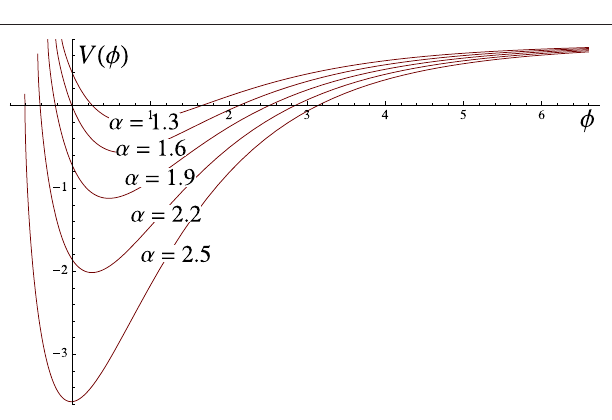
FIGURE 4 | This figure depicts the potential V values of α in the physically-interesting range, α class of potentials allowing for a (finite) period of slow-roll inflation, followed by